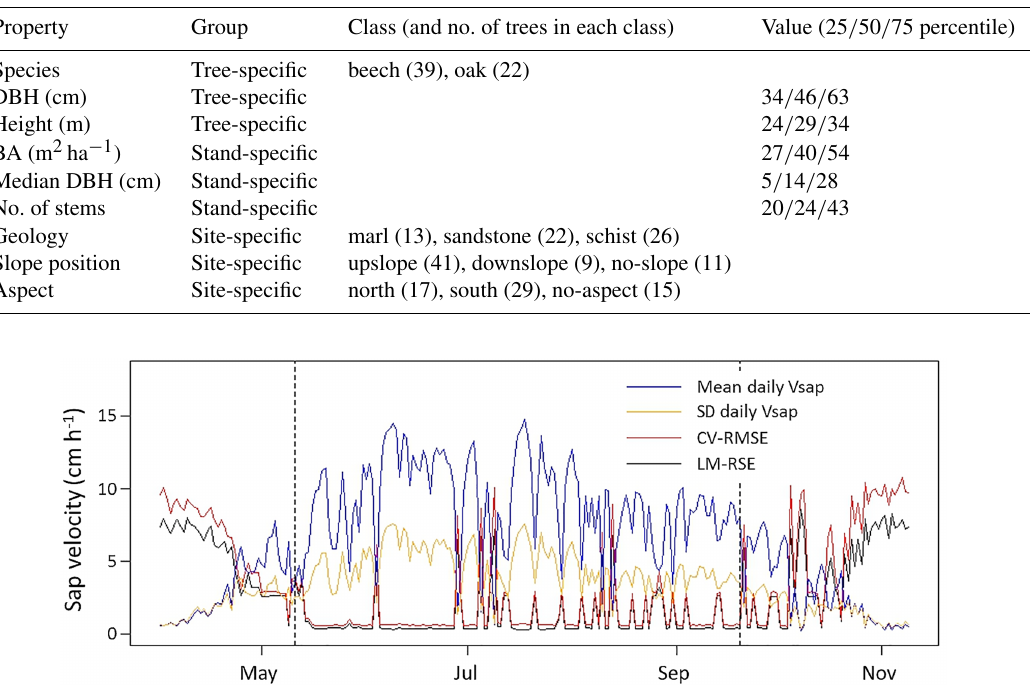
Figure 2. Comparison of residual standard error of the original linear models (LM-RSE) and the root mean square error of a 10-fold cross- validation (CV-RMSE), in relation to mean and standard deviation of daily sap velocities ( V sap ). The dashed lines indicate the beginning and end of the focus period with a fully developed canopy.